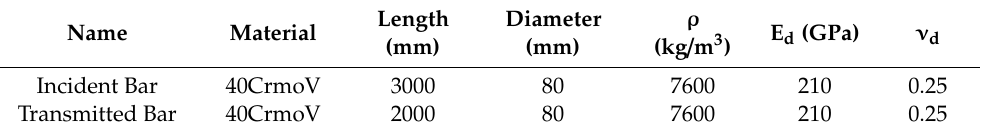
Figure 1. Split-Hopkinson pressure bar (SHPB) test system and specimen geometry. Table 1. Material parameters of Split-Hopkinson pressure